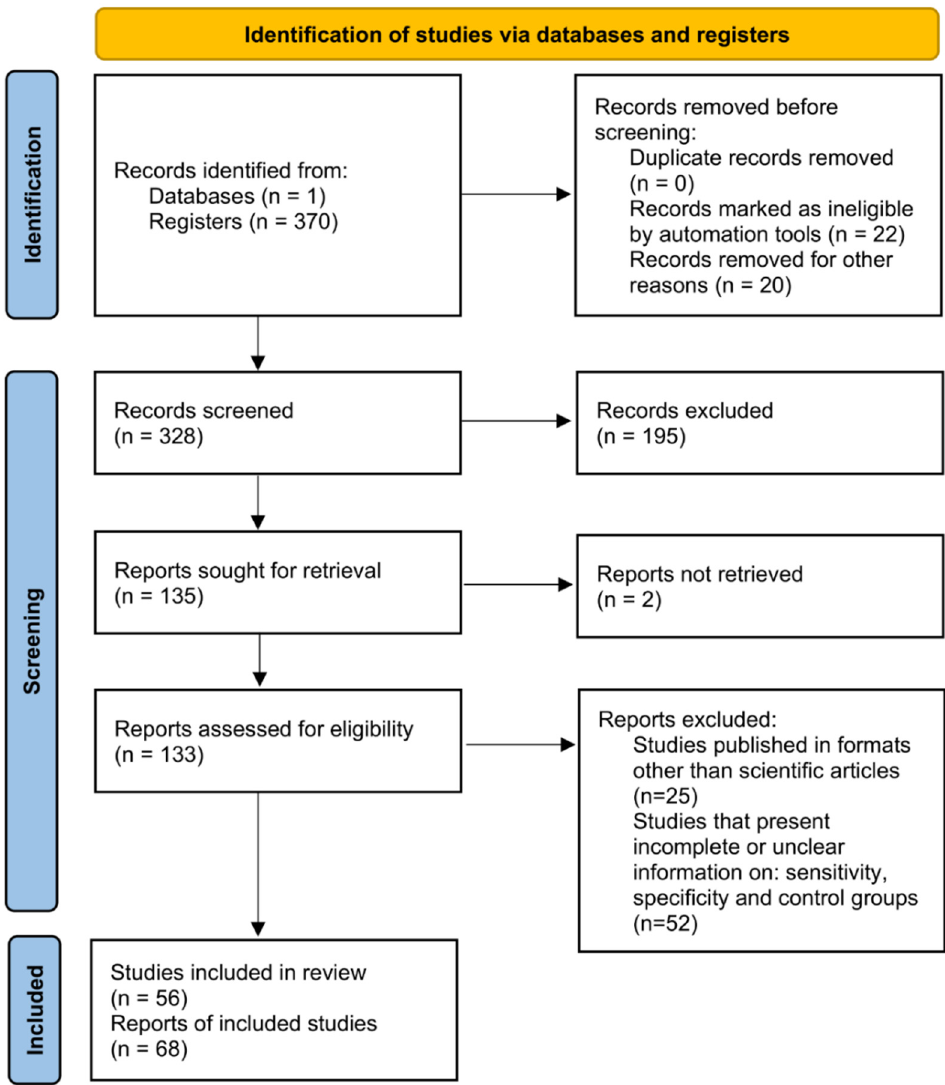
Figure 1. Systematic review and meta-analysis workflow diagram. Besides, the number of selected studies for PCR, qPCR, Xenodiagnosis, ELISA, CFT, IFAT, HmT, RIPA, and WB was: 107, 26, 9, 136, 7, 38, 24, 8, and 15, respectively (Figure 2B). Though using a three-step eligibility criterion, 237 articles were excluded in the first two steps. In the last stage of data extraction, 41 articles were excluded. Therefore, 92 arti- cles were selected for meta-analysis. Additionally, data on geographical characteristics extracted from the 92 selected articles were analyzed (Figure 3); while in most of the studies, the diagnostic technique employed was ELISA (Figure 3A); additionally, the American continent has carried out a greater number of studies, with Brazil being the country where a higher number of the population of Chagasic patients, in general, have been studied (Figure